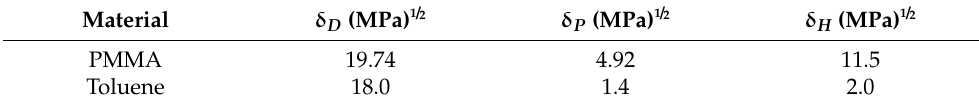
Table 2. Hansen solubility parameters for PMMA and toluene. Data from Refs. [22,23]. Material